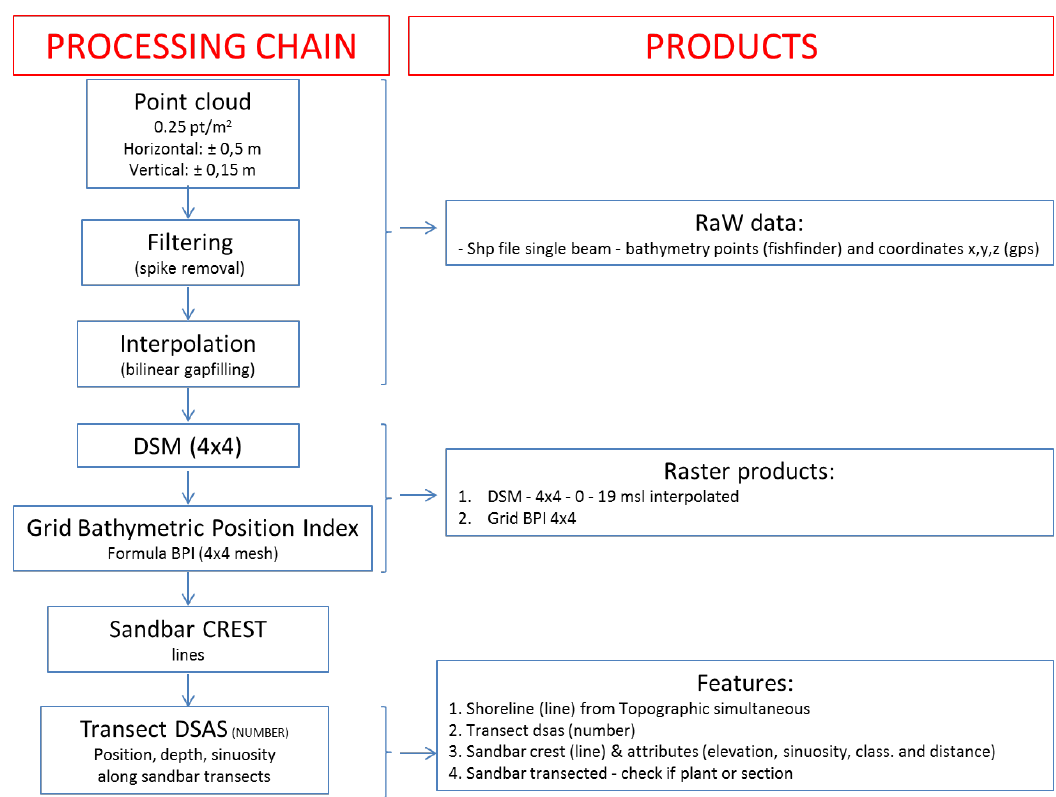
Figure 4. Flowchart of the LiDAR processing chain (left) used in the present work and products (right).